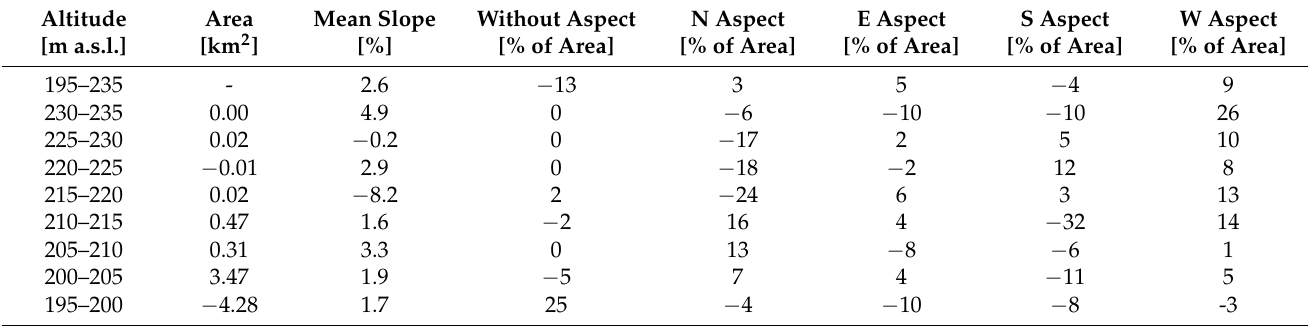
Table 1. Difference between values of topographic parameters from variant (B) and (A) based on the first method. Altitude [m